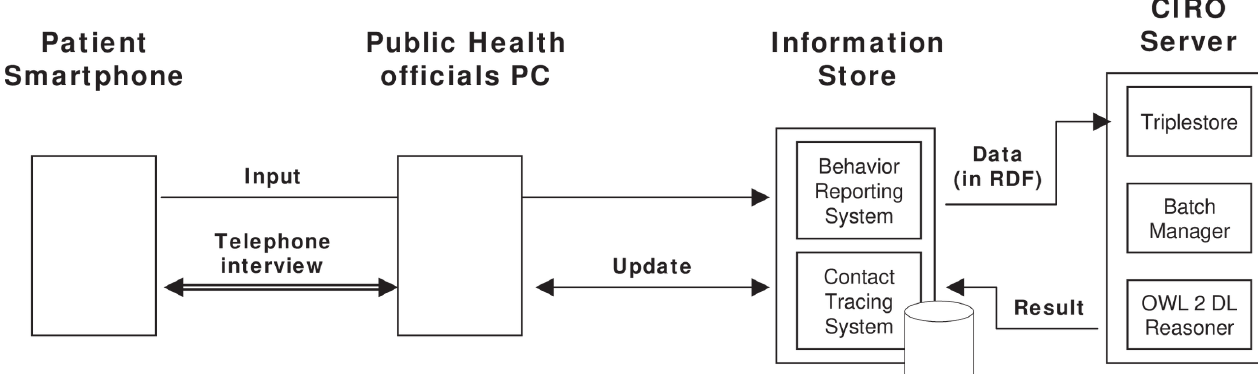
Fig 8. Behavior reporting and Infection risk